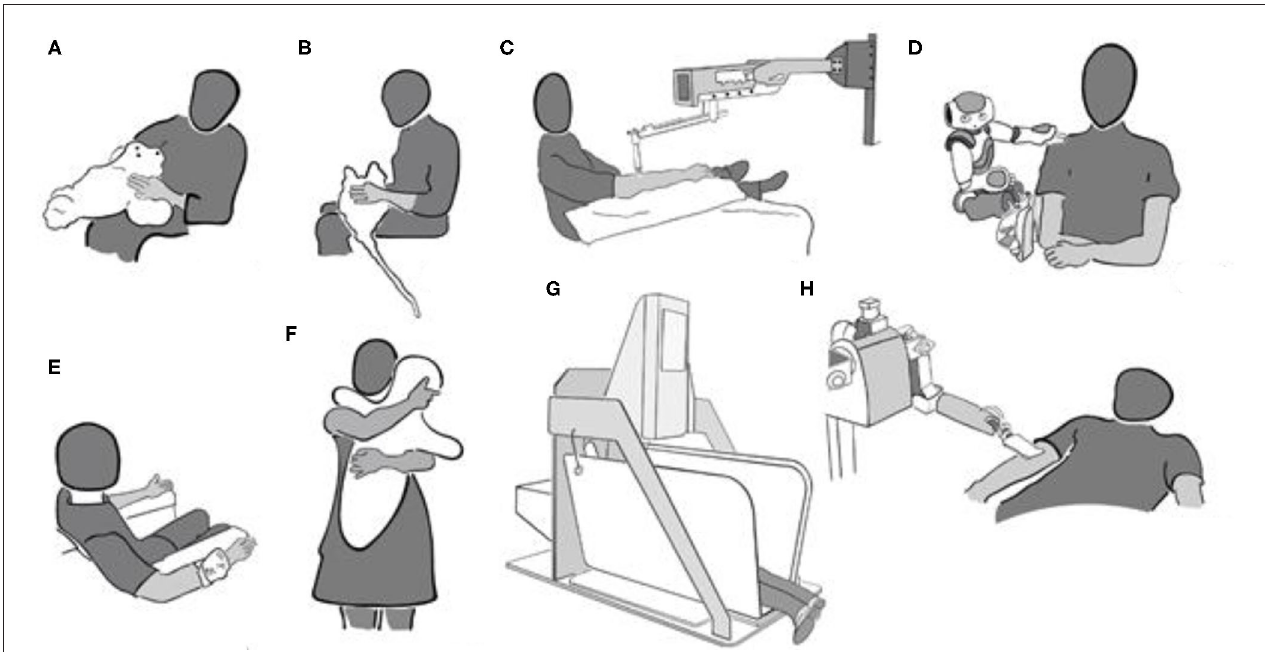
FIGURE 2 | (A–H) Schematic overview over devices used to perform touch.